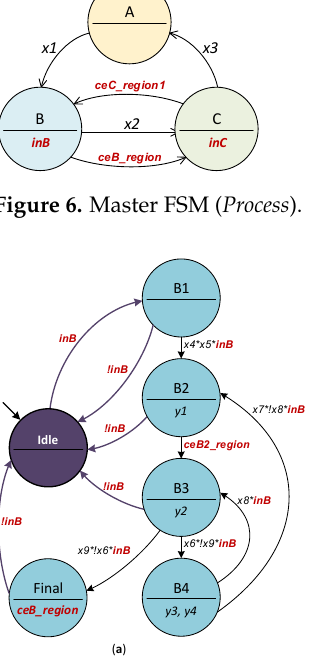
Figure 7. The exemplary slave FSMs: ( a ) B_region and ( b ) B2_region .